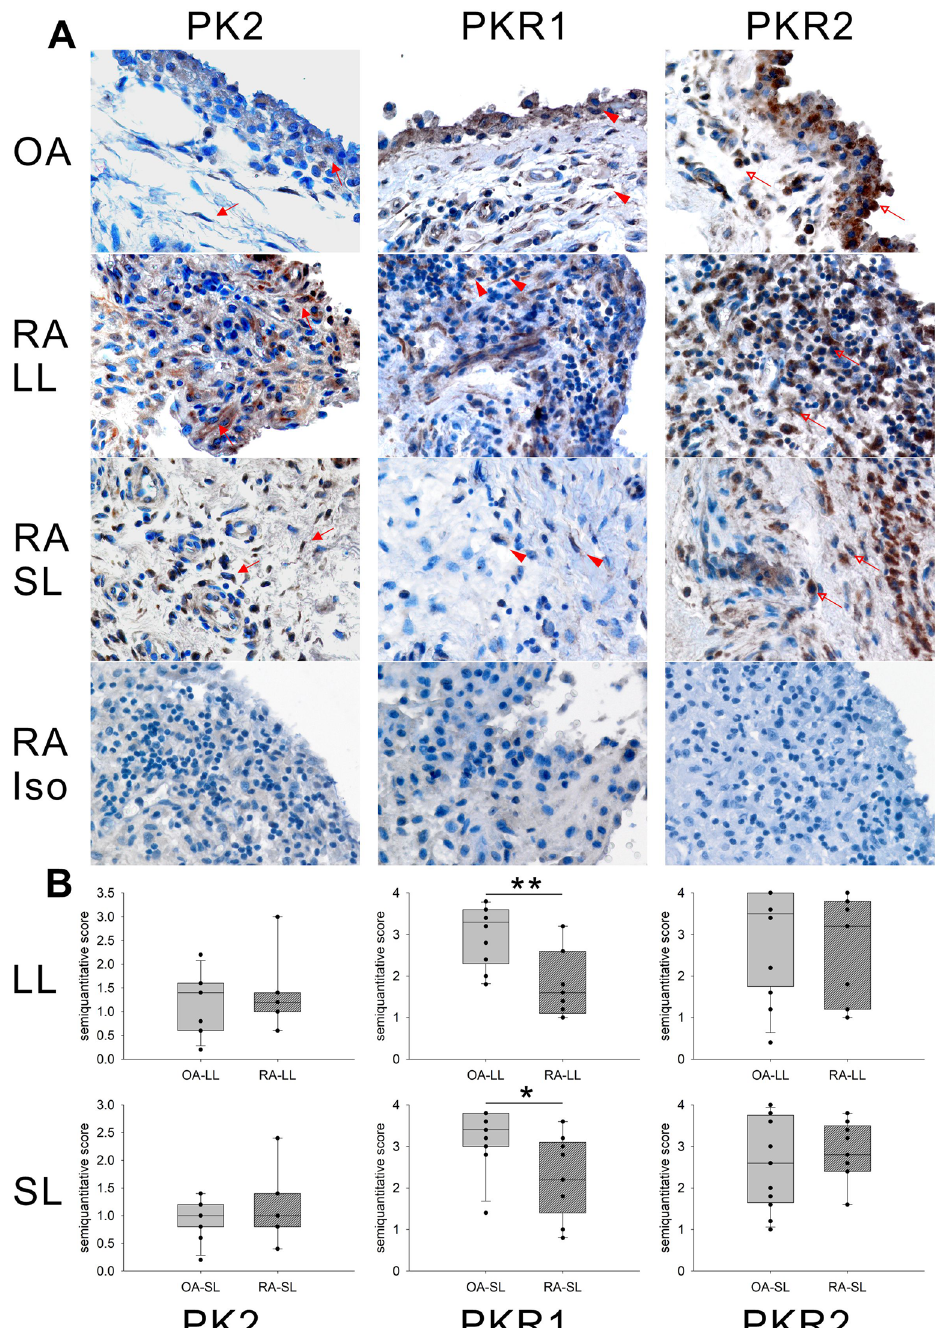
Figure 2. PK2, PKR1, and PKR2 expression in OA and RA synovial tissues. ( A ) Immunostaining of PK2 (left panel), PKR1 (middle panel), and PKR2 (right panel) proteins in synovial tissue from OA and RA patients. Brown staining indicates PK2- (red arrow), PKR1- (red arrowhead), or PKR2 (red open headed arrow)-positive cells (× 400) Staining with an isotype control as the primary antibody in RA synovial tissue is also demonstrated. ( B ) Semiquantitative results of PK2, PKR1, and PKR2 expression. Semiquantification was performed using a scoring method (0–4) in the lining and sublining layers of synovial tissue. Data were presented as box plots, in which the boxes demonstrate the 25th and 75th percentiles, the lines within the boxes demonstrate the median, and the lines outside the boxes demonstrate the 10th and 90th percentiles. N = 8–10. For statistical analysis, the Mann–Whitney test was used. *p < 0.05, **p < 0.01. PK2 prokineticin 2, PKR1 prokineticin receptor 1, PKR2 prokineticin receptor 2, OA osteoarthritis, RA rheumatoid arthritis, Iso isotype control, SL sublining layer, LL lining